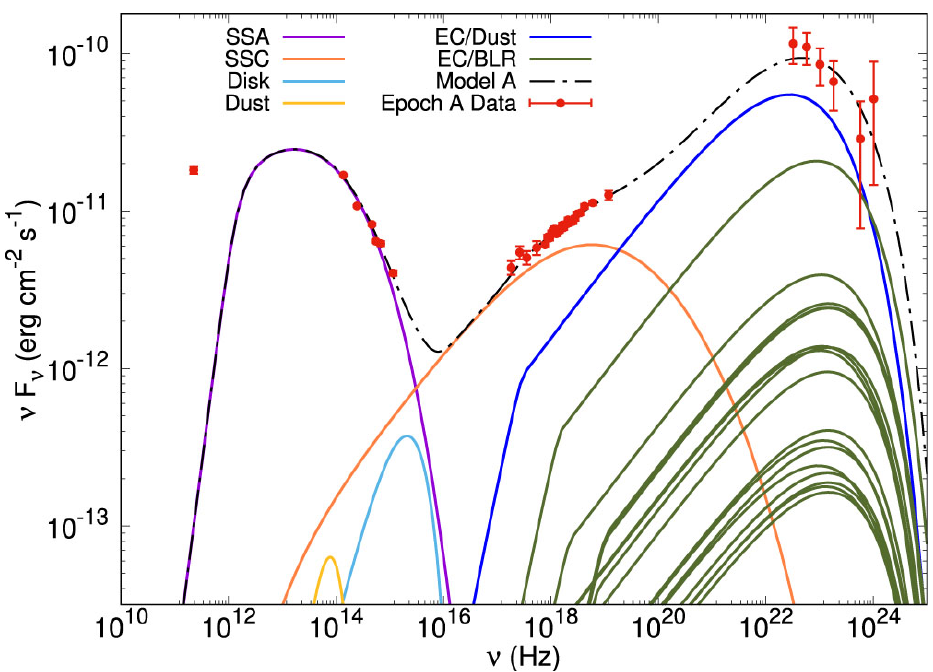
Figure 2. A typical stationary model, including a range of EIC components, for the FSRQ 3C279 (taken from [17] based on a code by [18]). Credit: [17] @AAS. Reproduced with